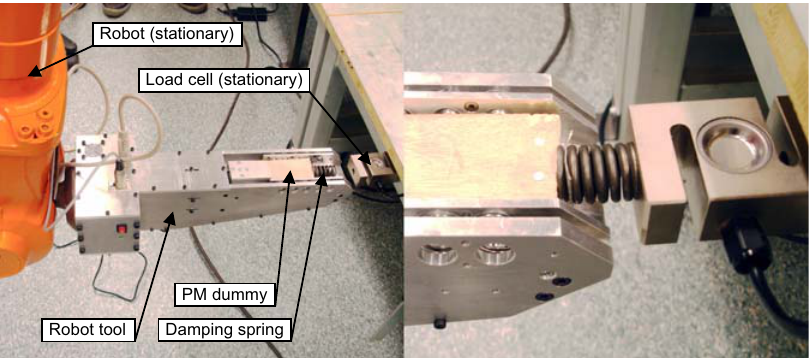
Figure 3. The robot tool assembly force experimental setup. ( Left ) The slide is in its home position; ( Right ) it has been fed forward pushing against the load